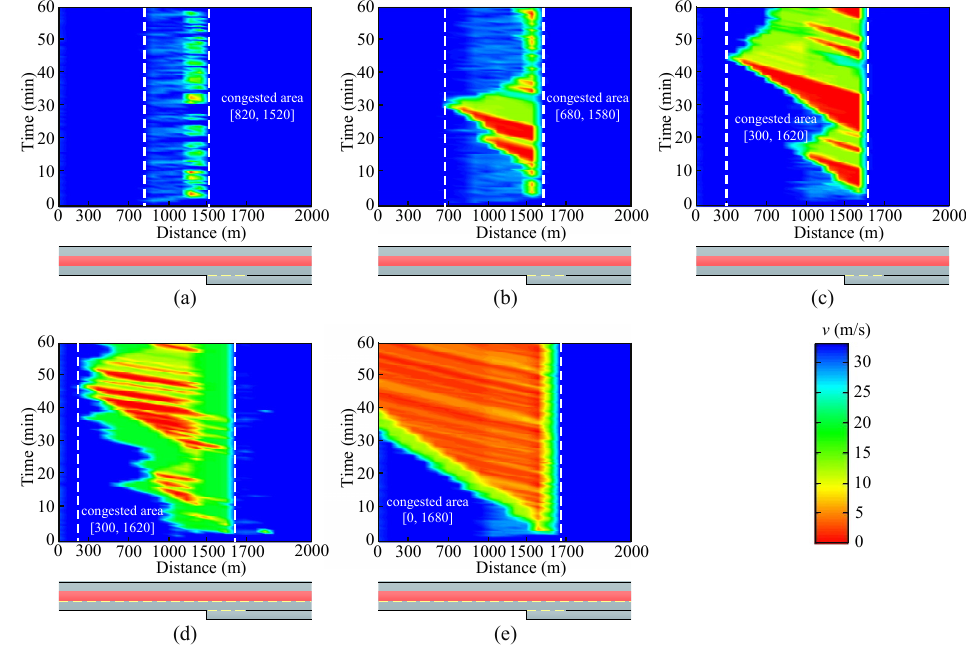
Figure 9. Spatiotemporal dynamics of average speed in the center lane. ( a ) P exit = 5%,( b ) P exit = 10%, ( c ) P exit = 15%, ( d ) P exit = 20%, and ( e ) P exit = 25%. Specially, the congested area is within [820 m, 1520 m] and the average speed is over 15 m/s, when P exit = 5%. The length of congested area respectively increases to 900 m and